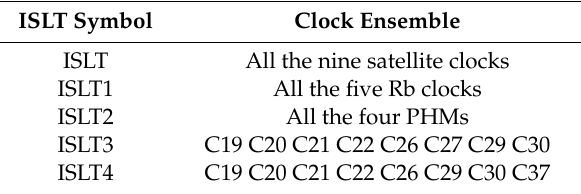
Figure 7. The frequency stability of the ISLTs kept by different clock ensembles.